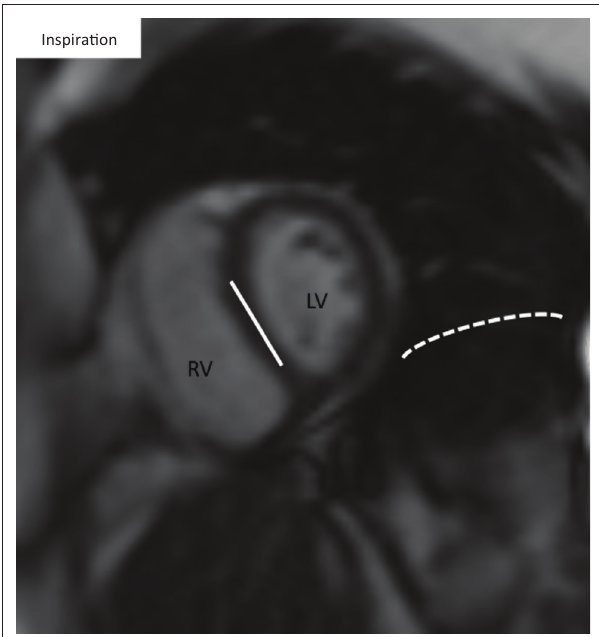
RV, right ventricle; LV, left ventricle. FIGURE 6: A 62-year-old man with constrictive pericarditis. Free-breathing cine SSFP image at the mid-ventricular level on the short-axis view demonstrates flattening (solid line) of the interventricular septum during inspiration when the diaphragm is flat (dotted line).